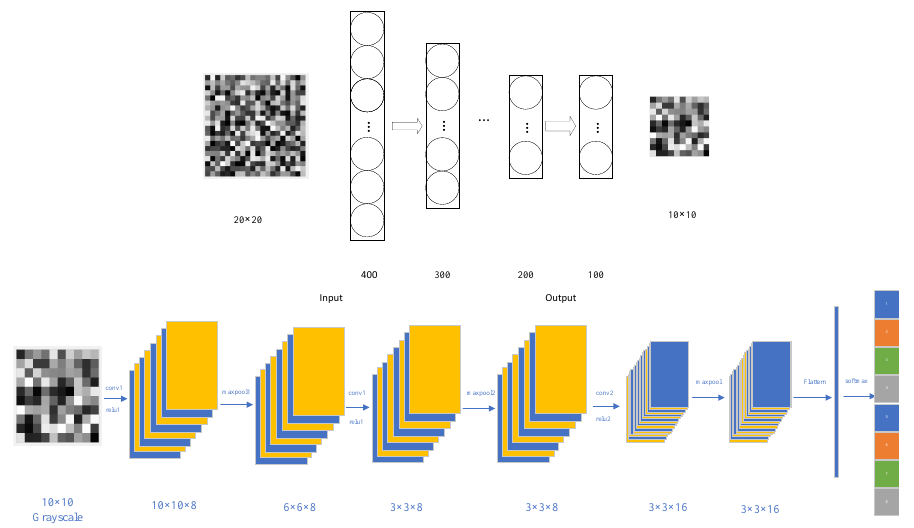
Figure 9. The specific structure of sPSDAE-CNN.